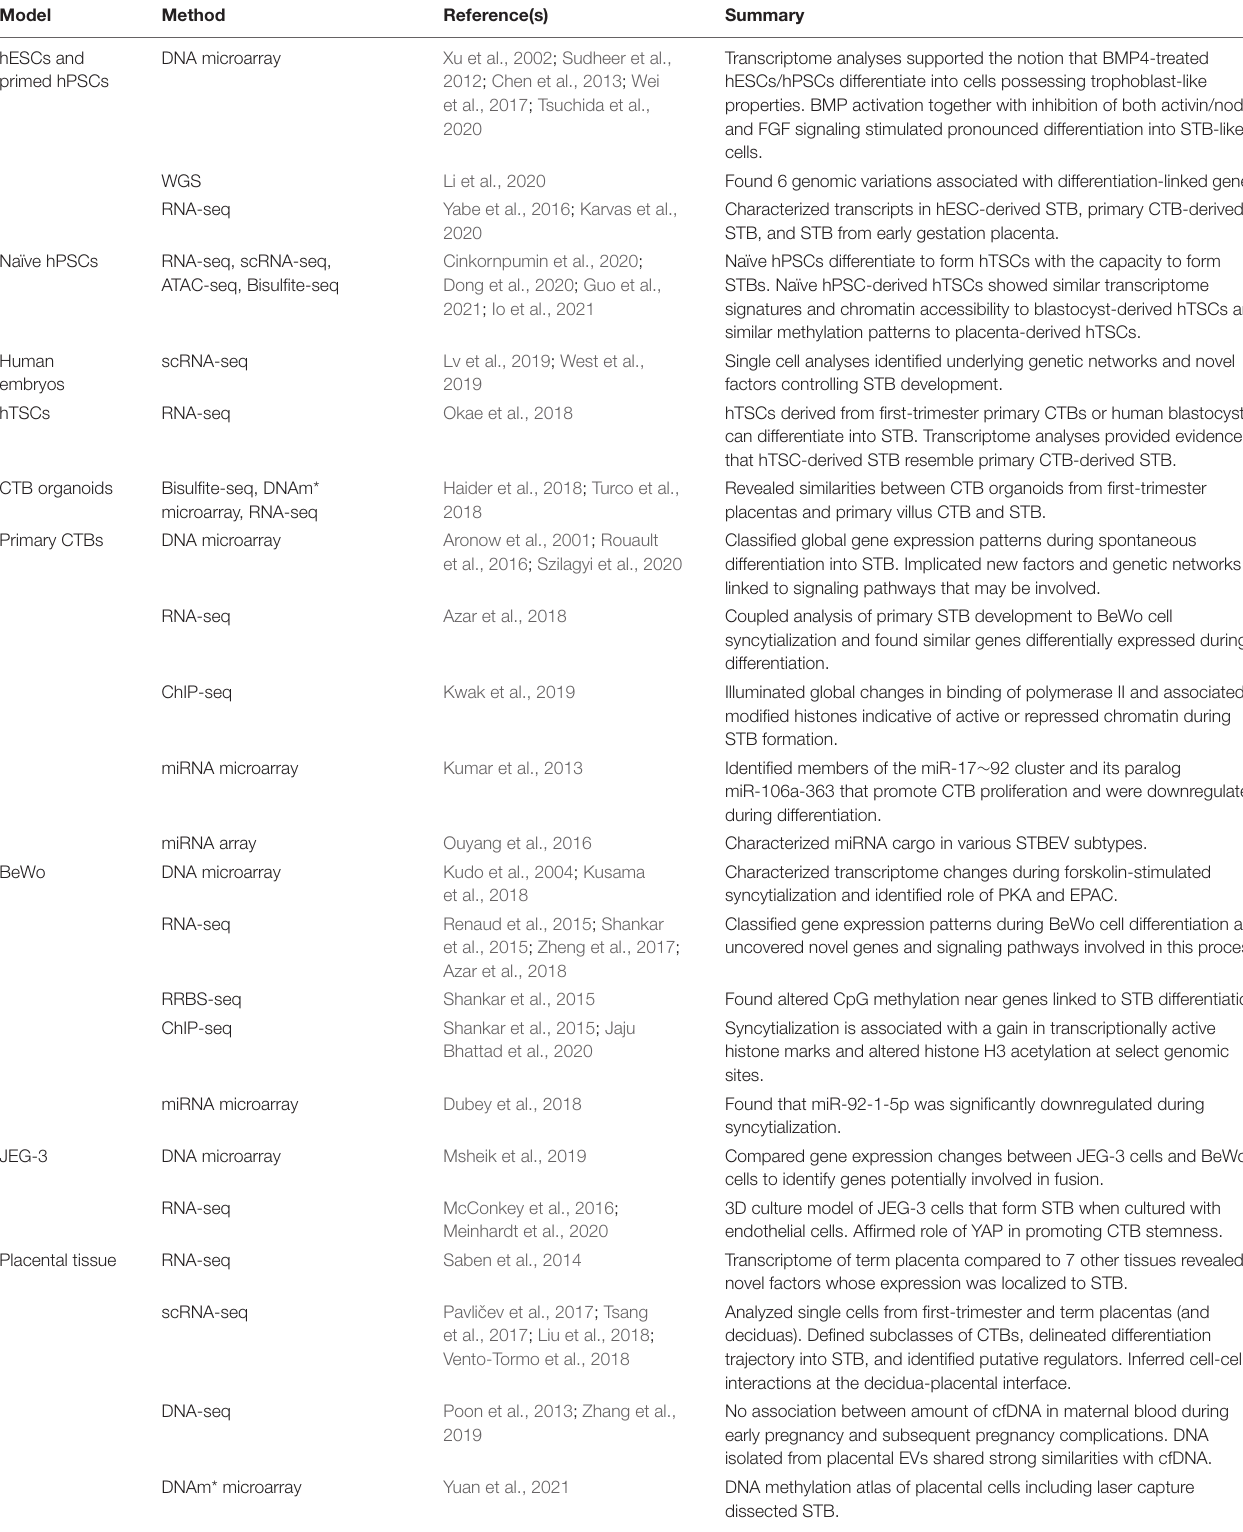
TABLE 2 | Examples of studies that used genomics, transcriptomics, and epigenomics to study